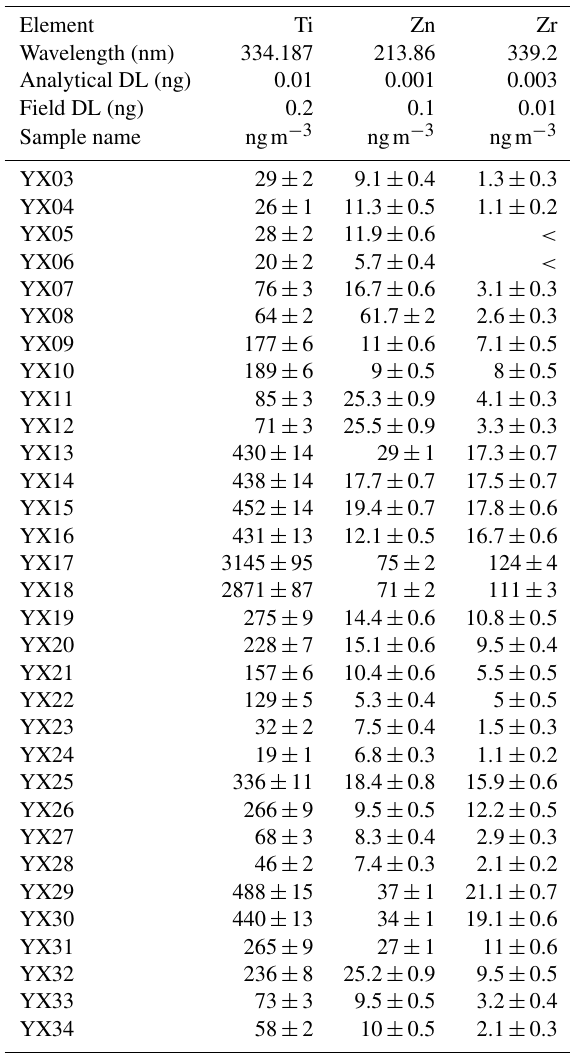
Table A3. Elemental air concentrations measured with ICP-AES,